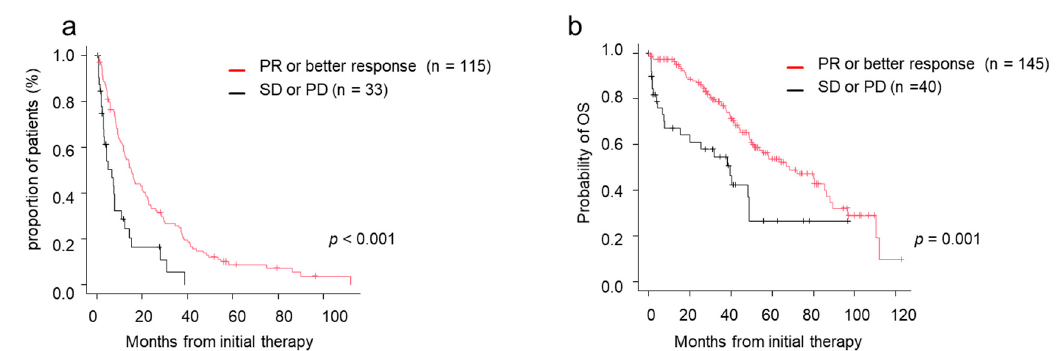
Figure 3. Time to next treatment (TTNT) and overall survival (OS) by response to initial therapy. ( a ) TTNT in those who achieved PR/better versus those who did not. ( b ) OS in those who achieved PR/better versus those who did not. CR, complete response; OS, overall survival; PD, progressive disease; PR, partial response; sCR, stringent complete response; SD, stable disease; TTNT, time to next treatment; VGPR, very good partial response.